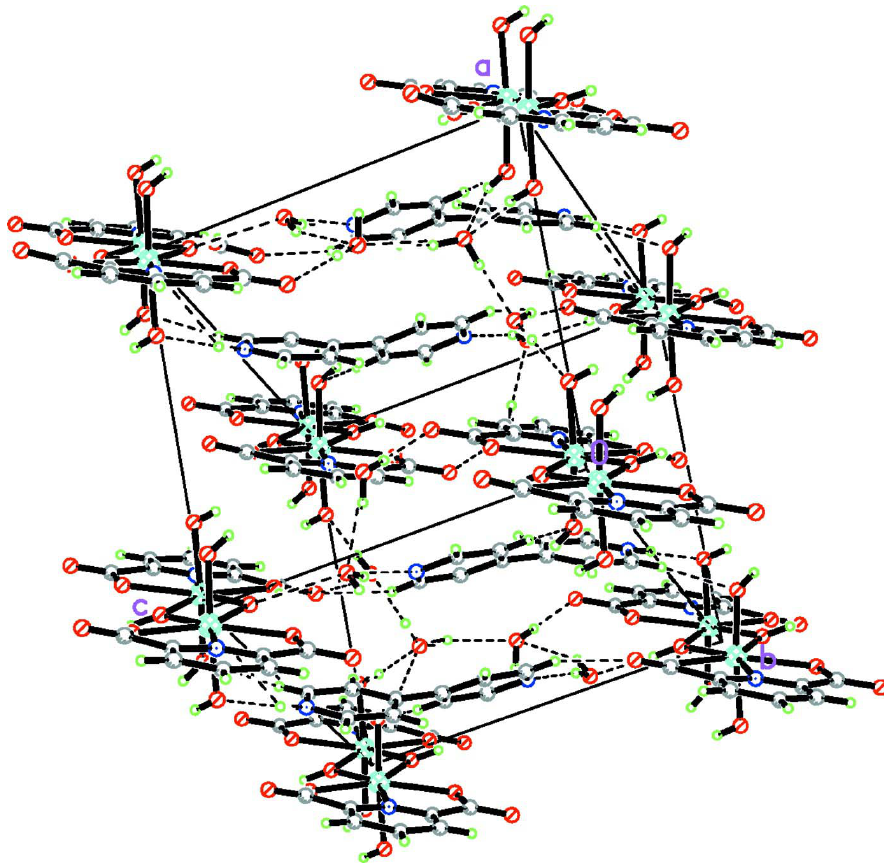
Figure 2 A view of the crystal packing of the title compound, with the hydrogen bonds shown as dashed lines.